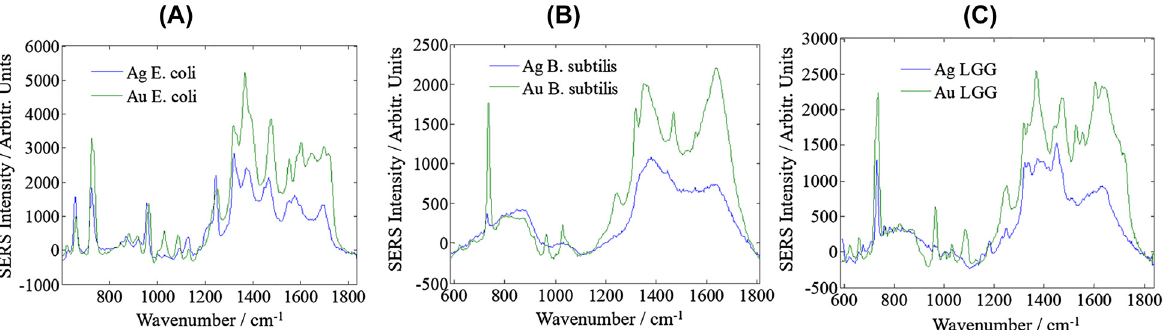
Figure 14: Comparison of surface enhanced Raman scattering (SERS) spectra from Escherichia coli (A), Lactobacillus rhamnosus GG (B), and Bacillus subtilis (C) suspensions. Raman spectra were obtained with either gold (Au) or silver (Ag) NPs. Note that bacterial suspension concentration used for Escherichia coli bacteria is 10 times higher with silver NPs than with Au NPs. Reprinted with permission from Akanny et al. [72]: John Wiley and Sons, Copyright